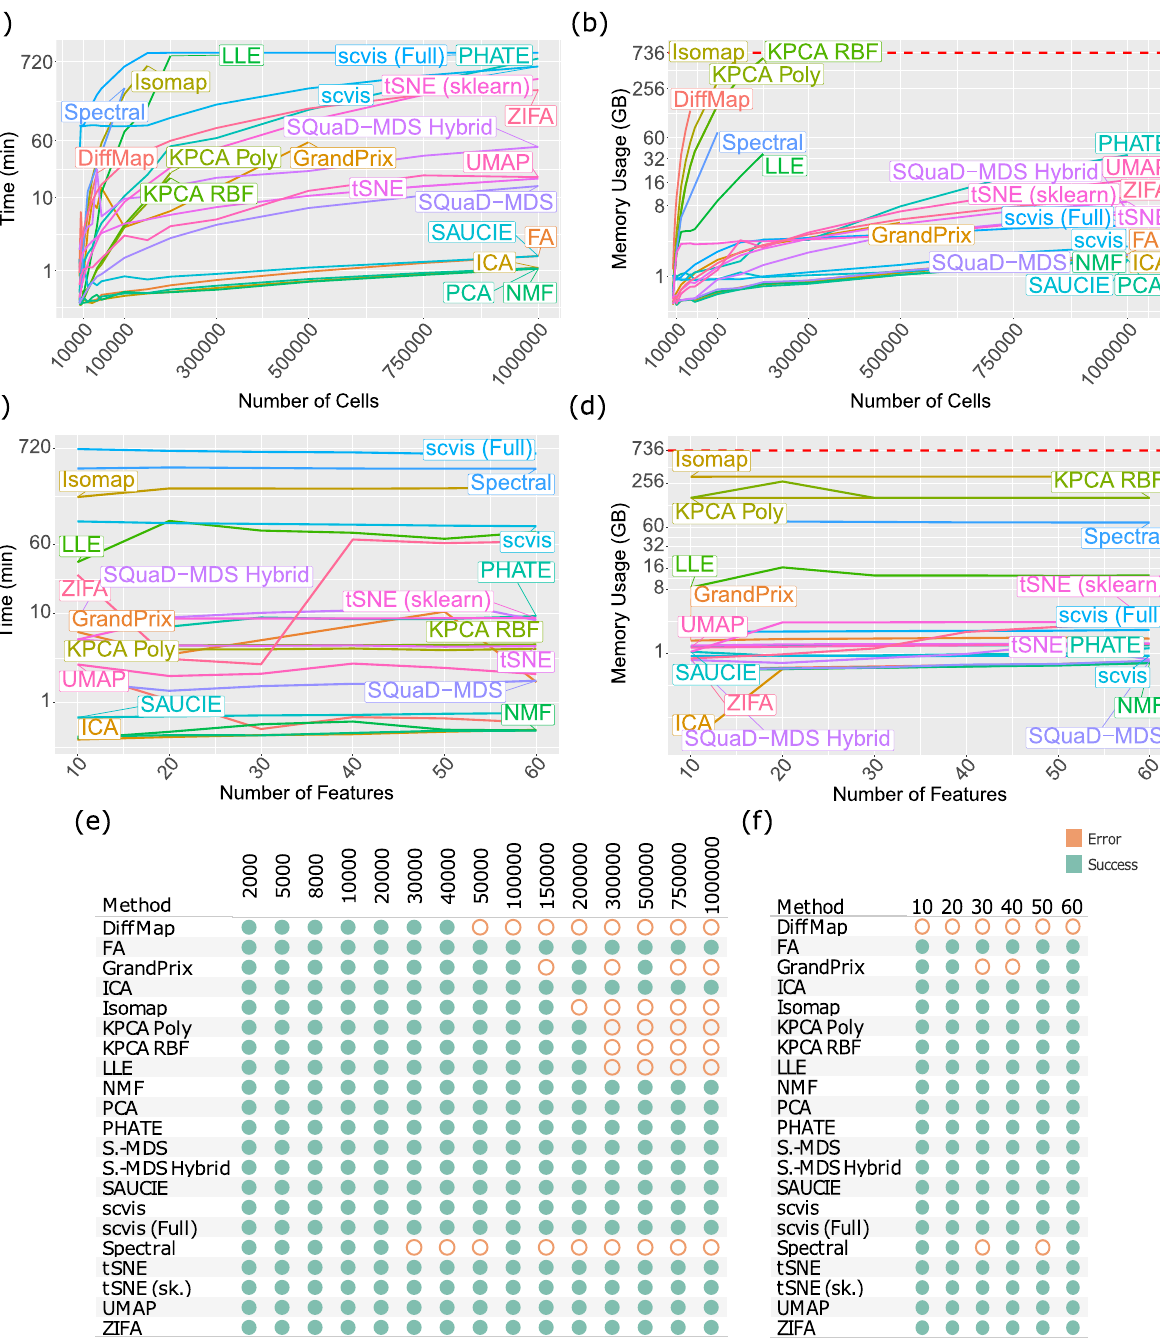
features. e , f WhethertheDRmethodsabortwitherrorduringtheruntime/memory benchmarking analyses in each cell number group ( e ) and protein feature number group ( f ). Source data are provided as a Source Data fi